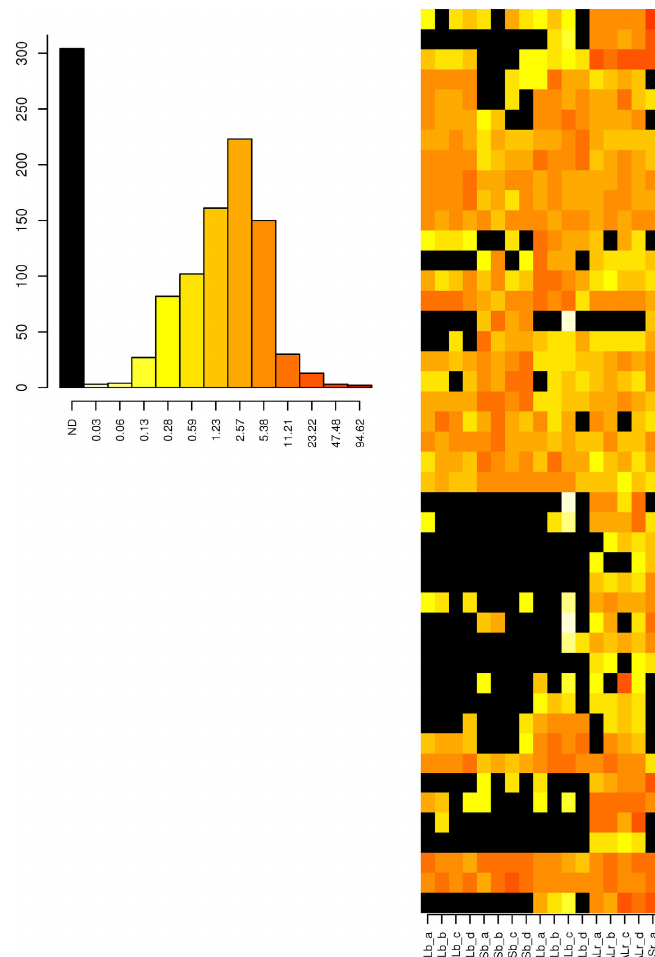
indicate the number of the NCBI GenBank accession that was most similar to the OTU representative sequence. A strong increase in abundance was indicated by not detecting the OTU in the bulk soil (black) or only in one or two samples present (yellow), raising to a high abundance in the rhizosphere which was indicated by orange to red color. Asterisks indicate a significantly increased abundance of that OTU in the rhizosphere compared to bulk